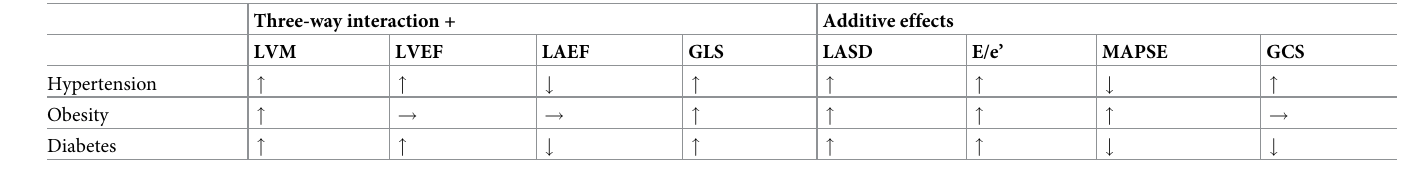
Table 4. Summary of